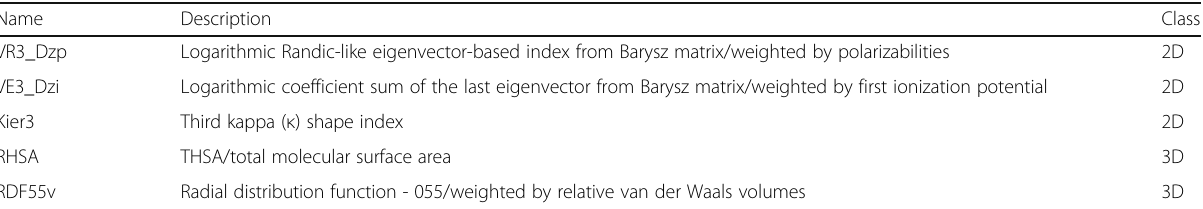
Table 2 Description and class of molecular descriptors in the built